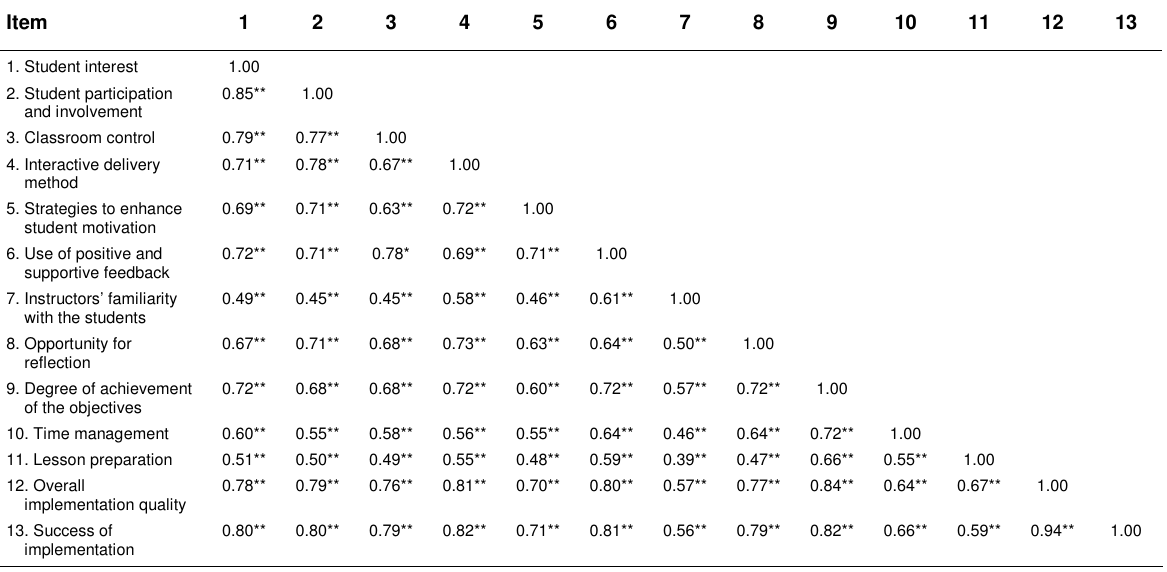
Intercorrelations among Items of the Curriculum Delivery